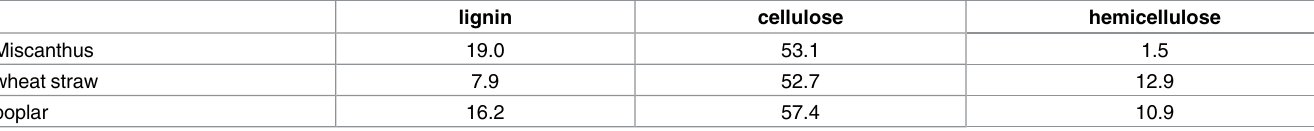
Table 1. Composition of pretreatedlignocelluloses substrates, expressedas percentages of dry